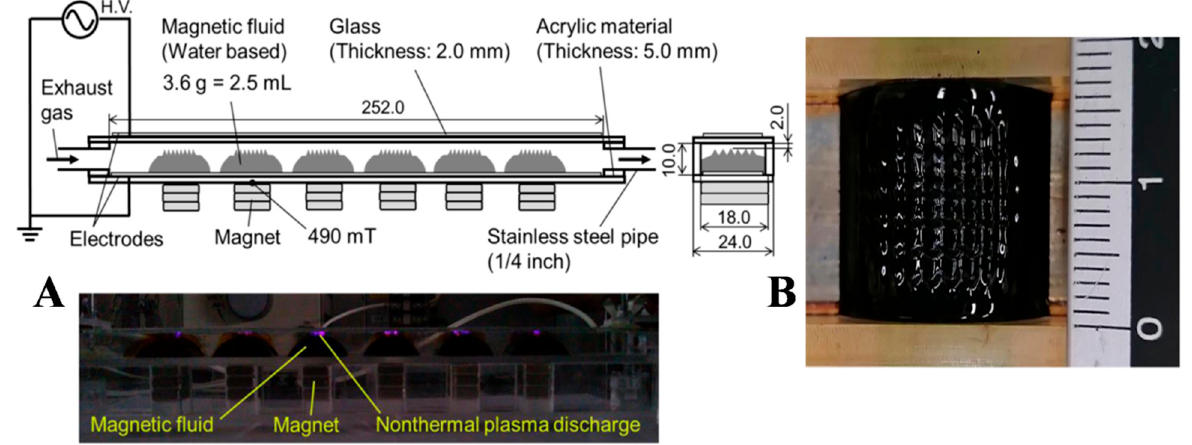
Figure 14. ( A ) Schematic of magnetic nanofluid filter and image of NTP discharge from magnetic nanofluid; ( B ) image of spikes in magnetic nanofluid with scale. Reprinted with permission from Ref. [140]. Copyright 2020, Elsevier.